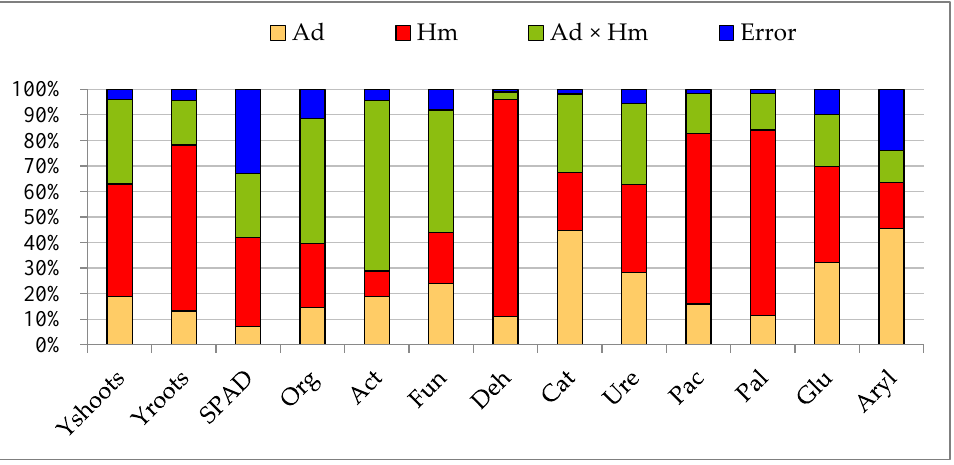
Figure 6. The contribution of independent variables (η 2 ) in influencing the plant yield, SPAD index, the number of microorganisms, and the activity of soil enzymes. Ad—adsorbent; HM— heavy metals; Y shoots —yield of shoots; Y roots —yield of roots; Org—organotrophic bacteria;